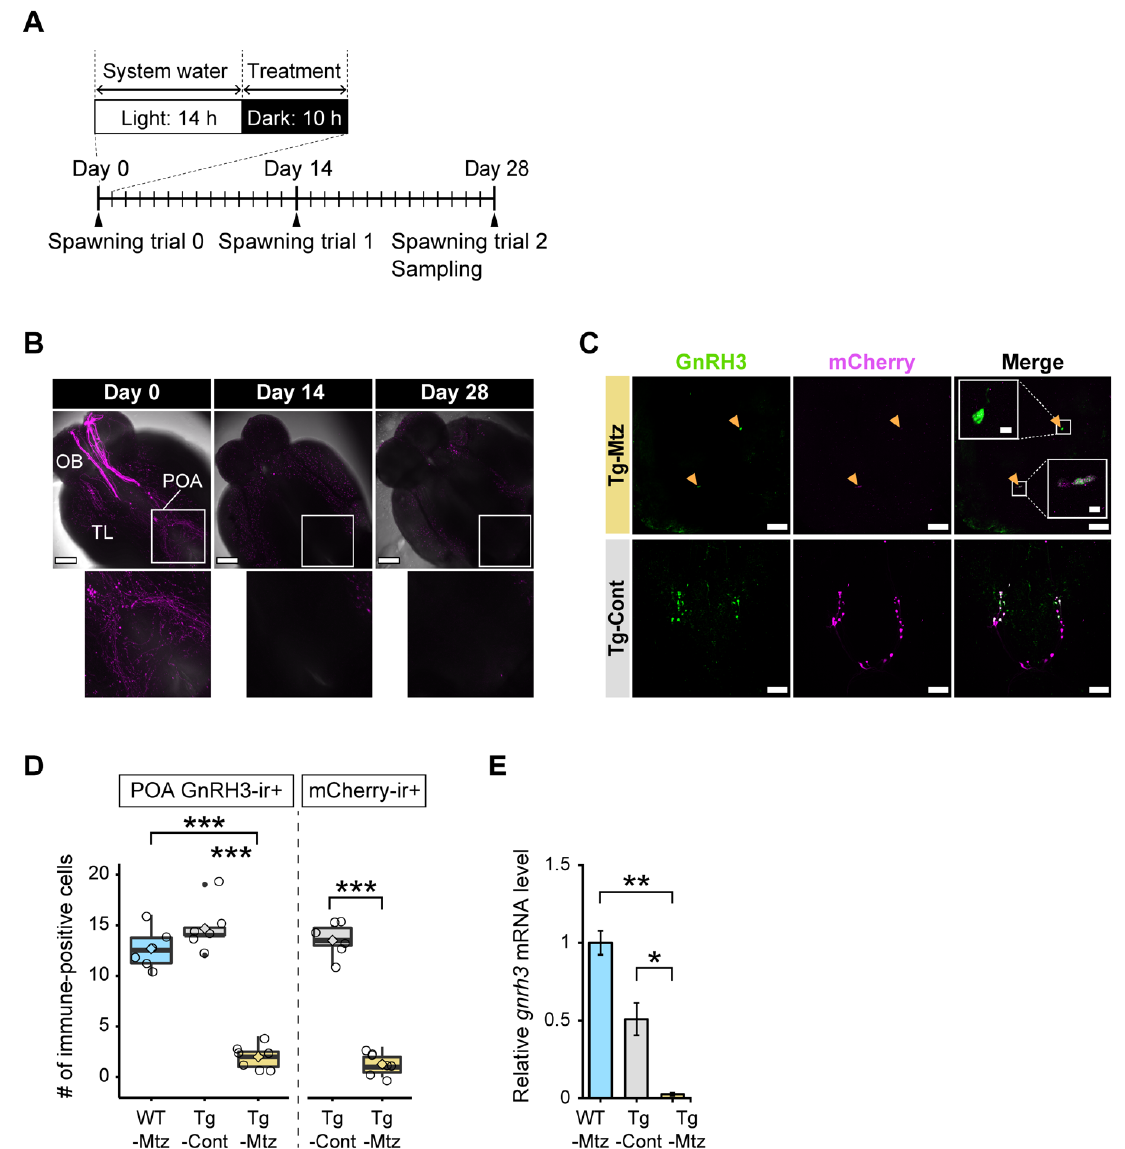
Figure 1. GnRH3 neuronal ablation is validated in the brain at 28 days of treatment. ( A ) Treatment and analysis schedule. Fish were exposed to 2 mM Mtz daily during the dark phase for 28 days, and were sampled at 14 and 28 days into the treatment. ( B ) Top panel: confocal images of GnRH3 neu ‐ rons expressing NTR ‐ mCherry fusion protein (magenta) in whole brains from the Tg(gnrh3:Gal4ff; UAS:nfsb ‐ mCherry) fish before the treatment, and at 14 and 28 days of treatment. Bottom panel: POA ‐ zoomed images showing the boxed area from the top images. Scale bars, 200 μ m. ( C ) Confocal im ‐ ages of co ‐ immunostaining of GnRH3 ‐ associated peptide (green) and mCherry (magenta) in the whole brain of Tg ‐ Mtz (top panels) and Tg ‐ Cont (bottom panels) at 28 days of treatment. GnRH3 neuron cell bodies co ‐ localized with mCherry in Tg ‐ Mtz are labeled by arrowheads. Scale bars, 100 μ m. Insets, zoomed images of GnRH3 ‐ ir and mCherry ‐ ir neuron cell bodies co ‐ localization showing the boxed areas of the merged image in Tg ‐ Mtz. Scale bars, 10 μ m. ( D ) Numbers of GnRH3 ‐ positive cells (left) and mCherry ‐ positive cells (right) in the POA ( n = 6–7). ( E ) Relative gnrh3 mRNA levels in the whole brain ( n = 4 each). OB, olfactory bulb; TL, telencephalon; POA, preoptic area; ir, immu ‐ noreactive; WT ‐ Mtz, WT siblings treated with 2 mM metronidazole (Mtz); Tg ‐ Cont, Tg(gnrh3:Gal4ff; UAS:nfsb ‐ mCherry) treated with vehicle; Tg ‐ Mtz, Tg(gnrh3:Gal4ff; UAS:nfsb ‐ mCherry) treated with 2 mM Mtz. *, p < 0.05; **, p < 0.01; ***, p < 0.001.